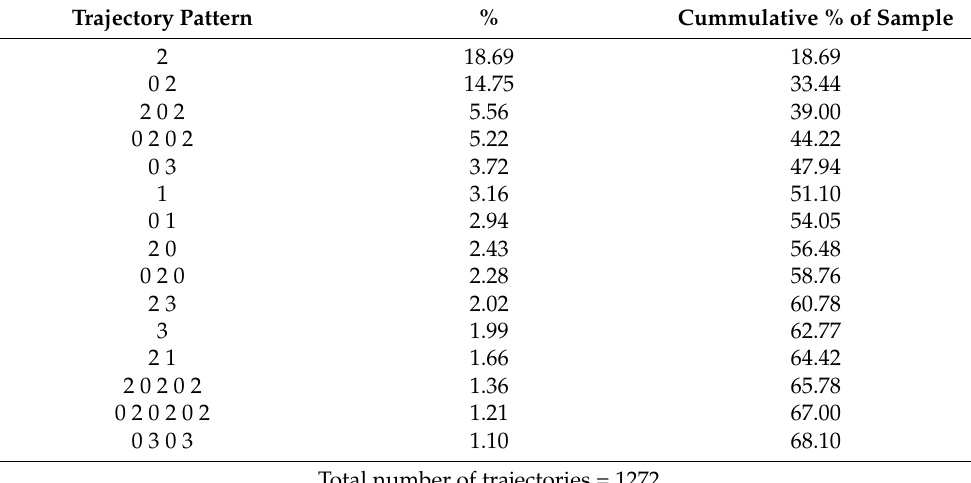
Table A1. List of the 15 most frequent patterns of educational mismatch trajectories.